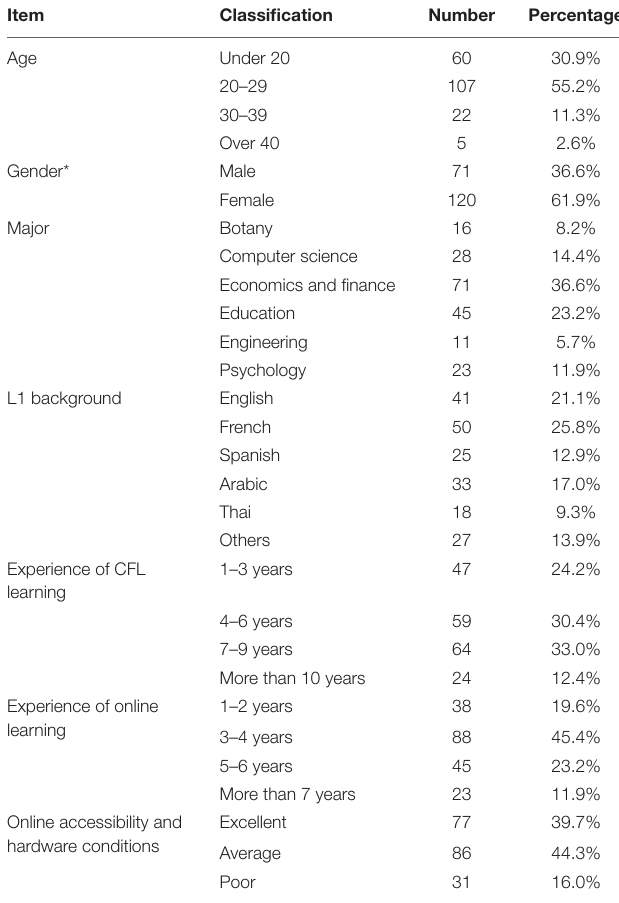
TABLE 1 | The demographic information of participants ( n =